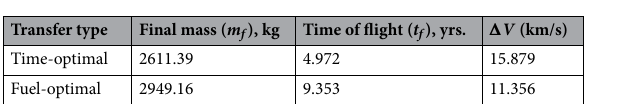
Figure 2. Earth-3671 dionysus fuel-optimal nominal transfer.